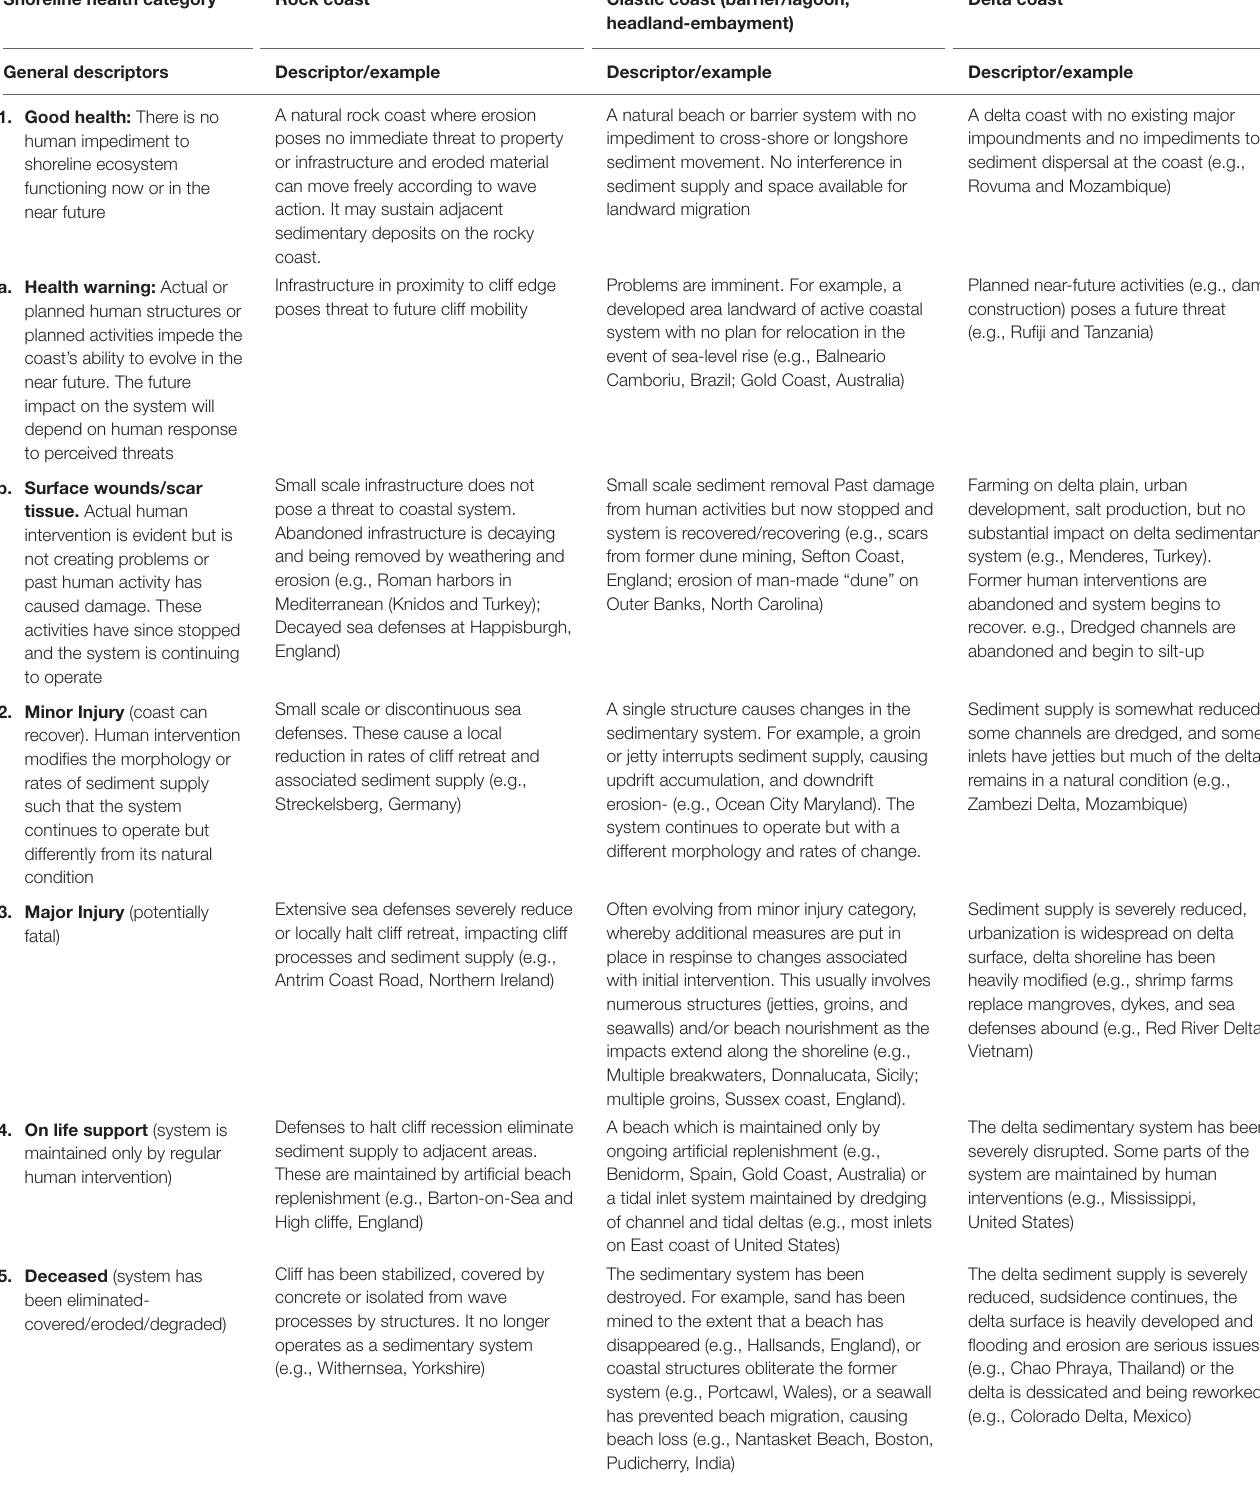
TABLE 1 | Shoreline health categories with descriptors for (i) cliffed (soft or hard rock cliffs), (ii) clastic (sand or gravel beaches, barriers, and headand-embayment coasts), and (iii) deltas. Shoreline health